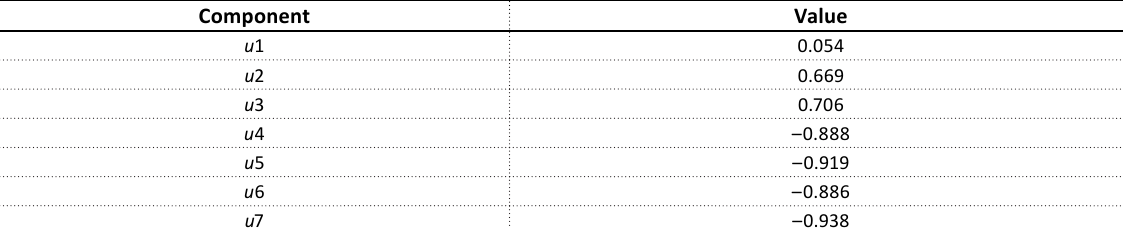
Table 5. Matrix of components (component matrix